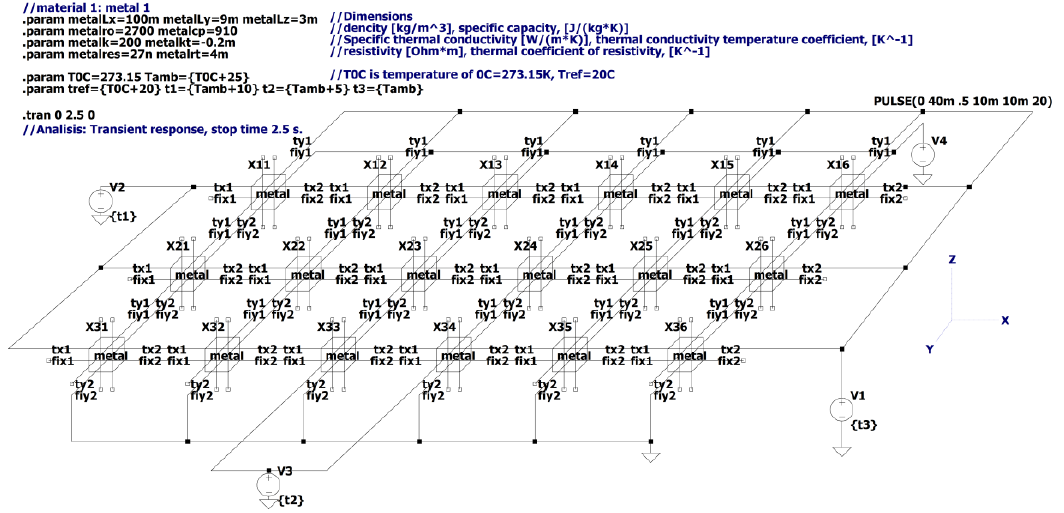
Figure 9. The electrical equivalent circuit in LTSpice schematic editor for the heat conduction problem from Figure 8. The circuit includes 18 blocks shown in Figure 6. The blocks are designated as X ij , where i is the row number and the j is a block’s number in the row.